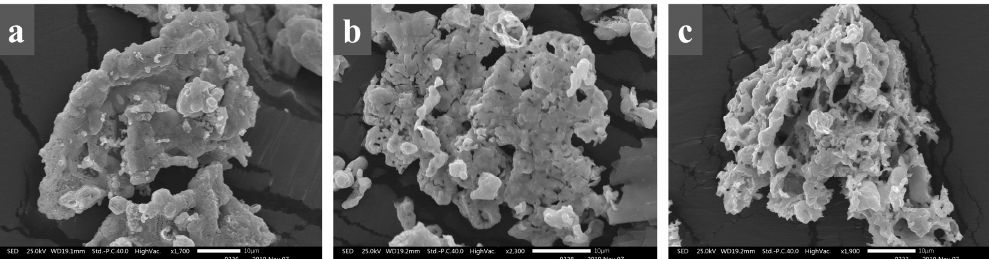
Figure 6. Microscopic morphology of the roasted product of pyrite and its leaching residue at di ff erent leaching times. ( a ) the roasted sample; ( b ) the leaching residue with a leaching time of 1 h; ( c ) the leaching residue with a leaching time of 4 h.